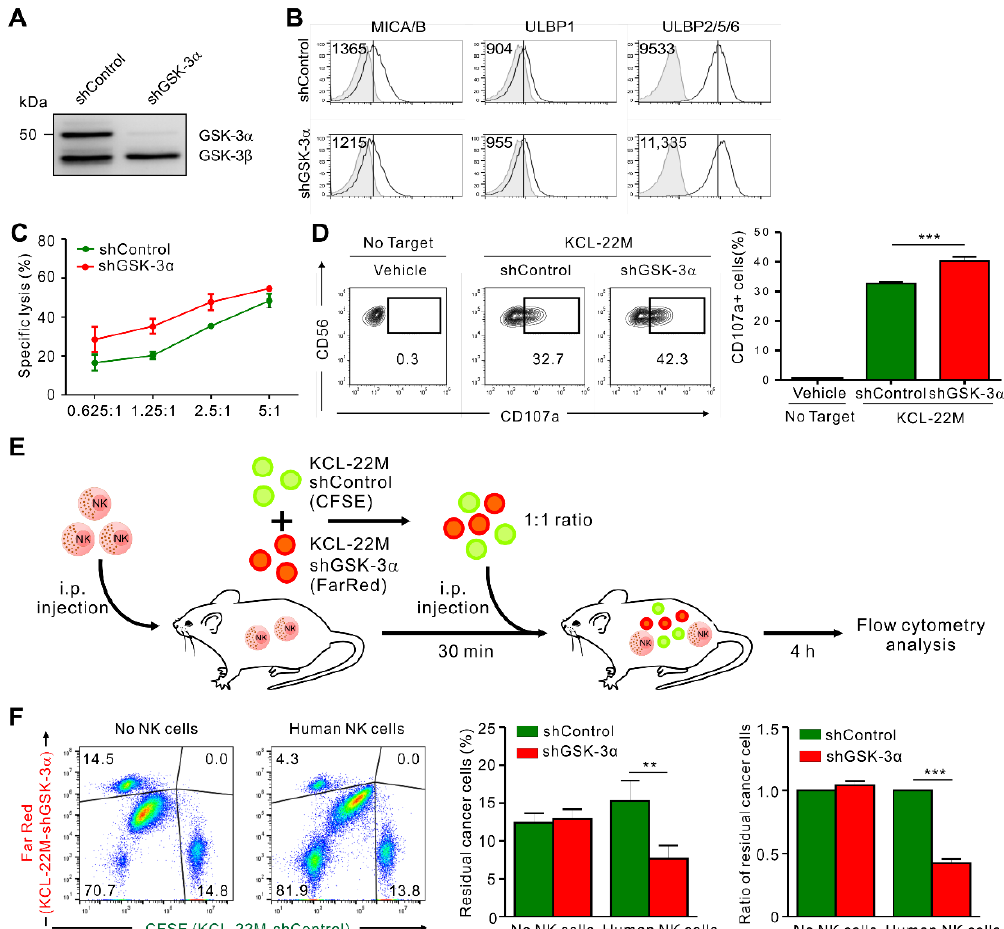
Figure 4. GSK-3 α knockdown enhances NK cell-mediated protection against T315I BCR-ABL KCL-22M cells. ( A ) Total cell lysates from KCL-22M cells transduced with lentivirus expressing control shRNA or an shRNA specific for GSK-3 α were immunoblotted for GSK-3 α / β . ( B ) Analysis of NKG2DL surface expression on KCL-22M cells transduced with control shRNA (shControl) or with stable knockdown of GSK-3 α (shGSK-3 α ). ( C ) NK cell cytotoxicity against KCL-22M cells with control shRNA (shControl) or stable knockdown of GSK-3 α (shGSK-3 α ) was assessed using a europium-based cytotoxicity assay at the indicated effector to target (E:T) cell ratios. ( D ) Degranulation assay with expanded primary NK cells against KCL-22M cells transduced with control shRNA (shControl) or with stable knockdown of GSK-3 α (shGSK-3 α ). Representative flow cytometry profile (left) and summary graph (right) demonstrating the percentage of CD107a + on CD3 - CD56 + NK cells. ( E ) In vivo leukemia rejection protocol. Immunodeficient NRG mice lacking B, T, and NK cells received an intraperitoneal injection with vehicle or expanded primary NK cells. For target cell preparation, KCL-22M-shControl cells were labeled with CFSE, while KCL-22M-shGSK-3 α cells were labeled with FarRed. A 1:1 target cell mix was then injected intraperitoneally into NRG mice 30 min post-injection of NK cells, and the rejection of KCL-22M-shGSK-3 α cells relative to KCL-22M-shControl cells in the peritoneal cavity was measured by flow cytometry after 4 h. ( F ) Flow cytometry of CFSE-stained KCL-22M-shControl and FarRed-stained KCL-22M-shGSK-3 α cells injected at a ratio of 1:1 (Input) into the mice ( n = 6 per group), followed by analysis of CFSE and FarRed in cells recovered from the peritoneal cavity of recipient mice 4 h later (Output) to assess NK cell killing activity in vivo. Representative flow cytometry profile (left), summary graph showing percentage (middle), and ratio (right) of residual cancer cells. Values represent the means ± s.d. Data are representative of at least three independent experiments. ** p < 0.01; *** p < 0.001.